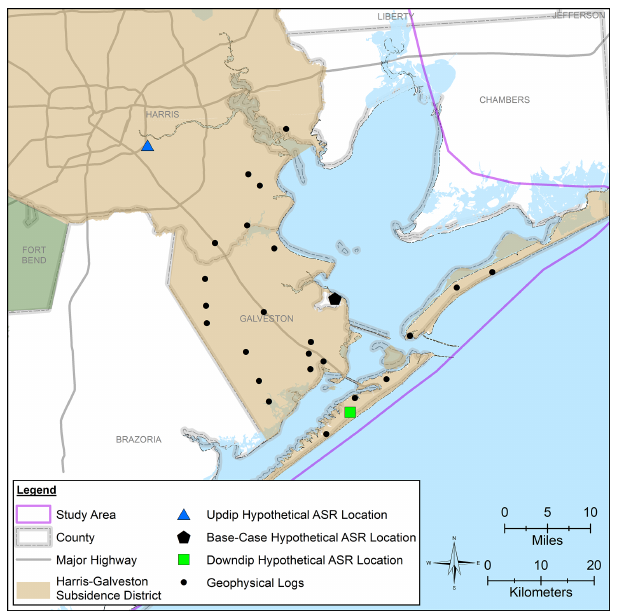
Figure 2. Location of the three hypothetical ASR project sites sim- ulated (Kelley and Deeds,